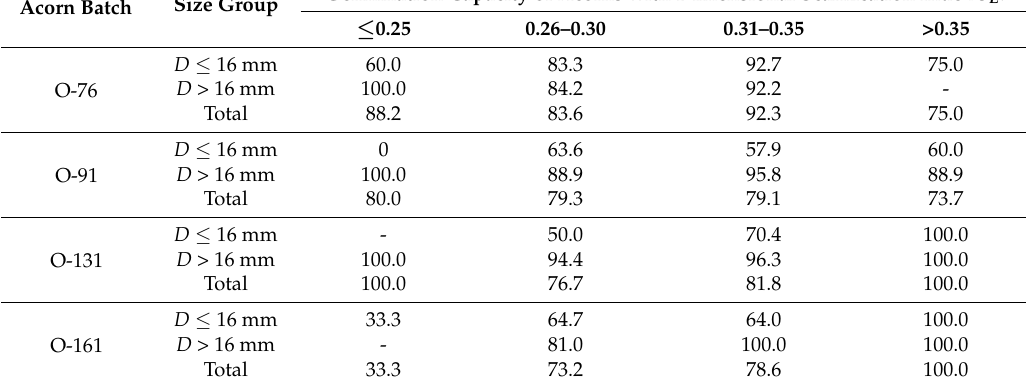
Table 3. Germination capacity of acorns from different size groups relative to their dimensional scarification index.